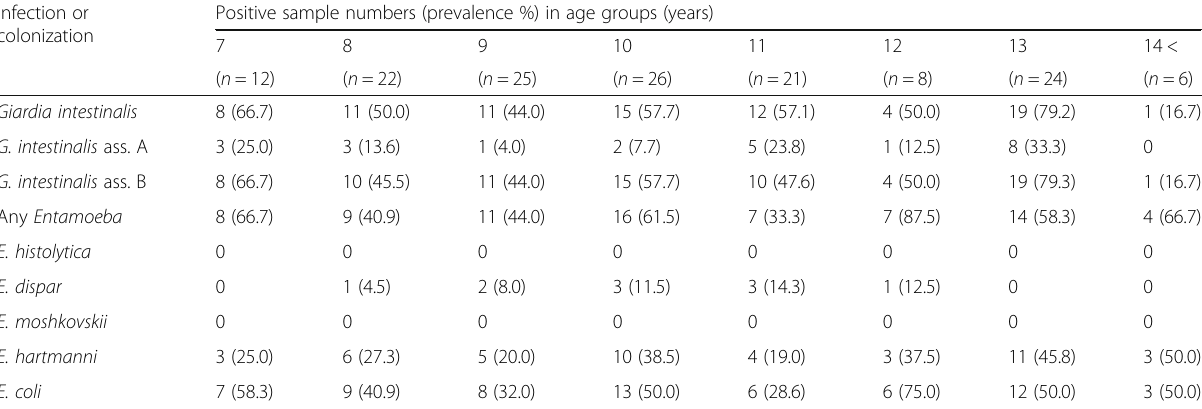
Table 2 Prevalences of intestinal protozoan parasites in age groups Infection or Positive sample numbers (prevalence %) in age groups colonization